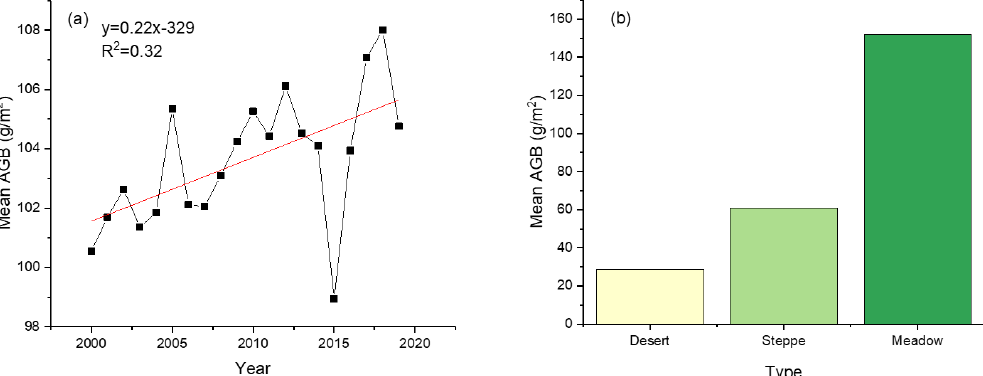
Figure 9. Variation trend for average grassland AGB on the QTP from 2000 to 2019 (a) and the average AGB of different grassland types (b) .